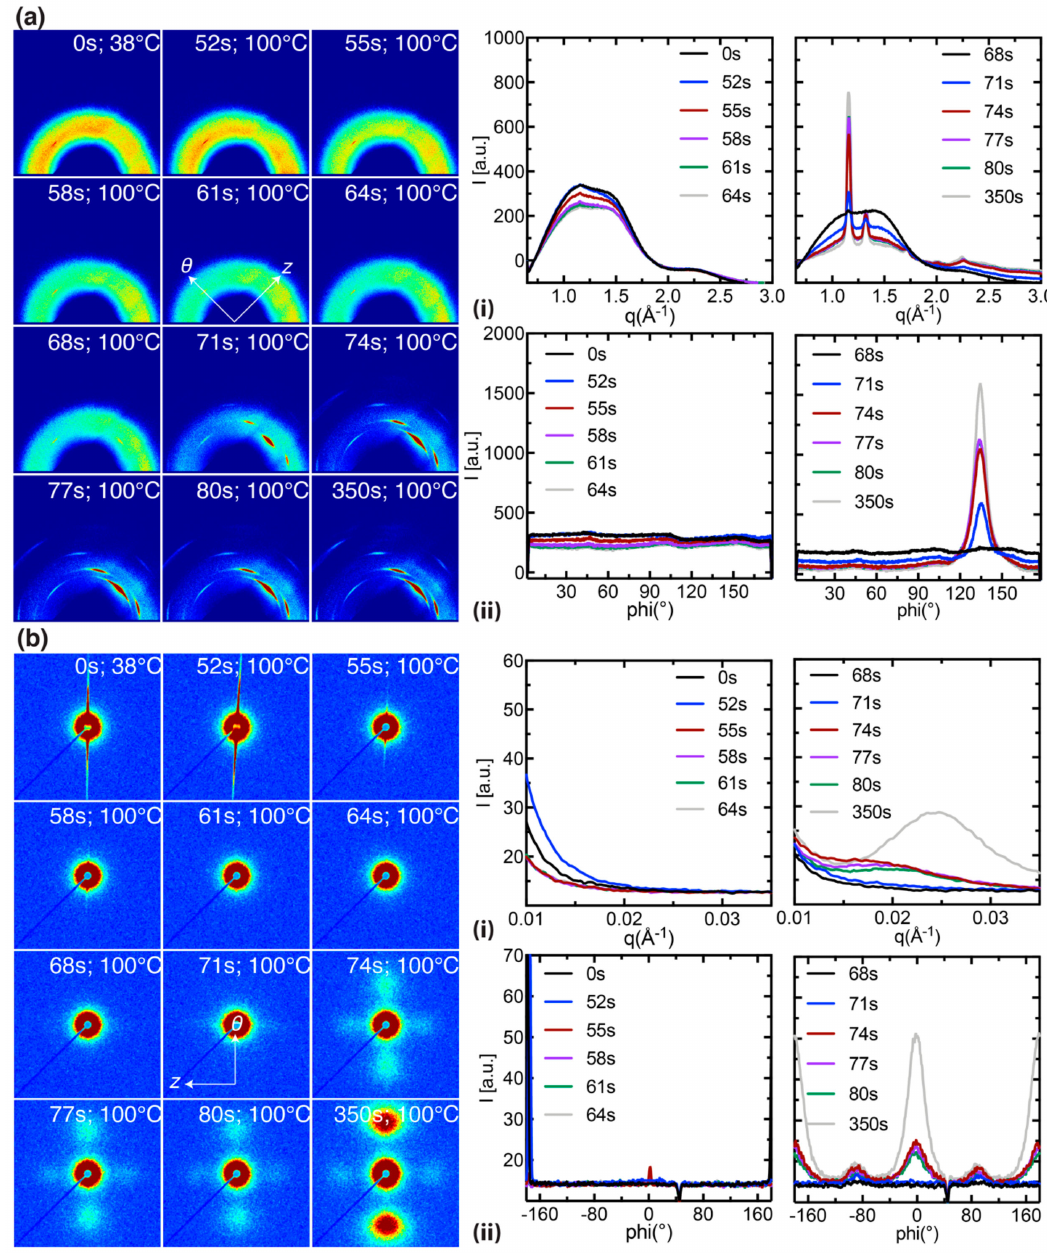
Figure 5. In situ ( a ) WAXS and ( b ) SAXS data acquired on a PLLA preform stretched at T e mold = 100 ◦ C. The diffraction patterns capture the transient heating and annealing steps (t < 350 s, T a mold = 100 ◦ C) and correspond to the temperature and strain profiles in Figures 3 and 4a. Diffraction patterns acquired during the cooling step (t > 350 s) can be found in Figure S17. The WAXS and SAXS data are presented as: 2D patterns; ( a , b , i ) azimuthally averaged intensity I(q); and ( a , b , ii ) radially averaged intensity I( ϕ